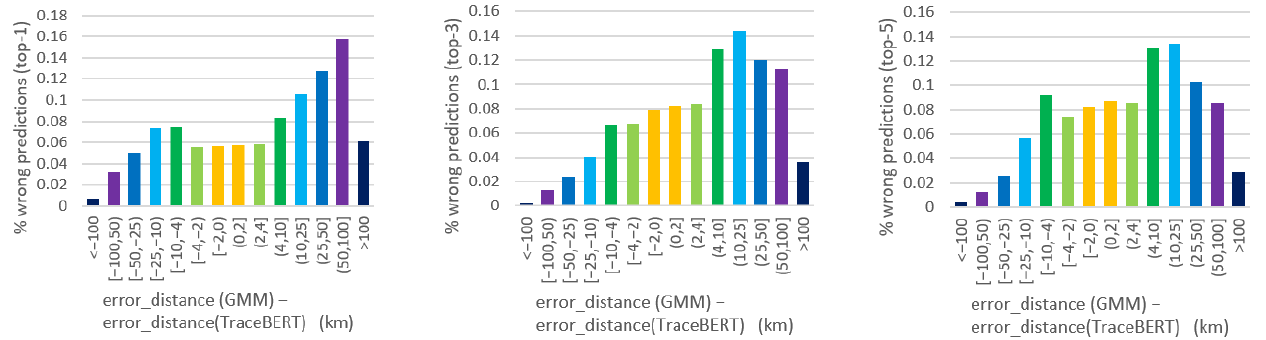
Figure 5. Bar graphs reporting the difference of error distance between GMM and TraceBERT in the case of common misprediction (from left to right : wrong predictions in top-1, top-3, and top-5, re- spectively).